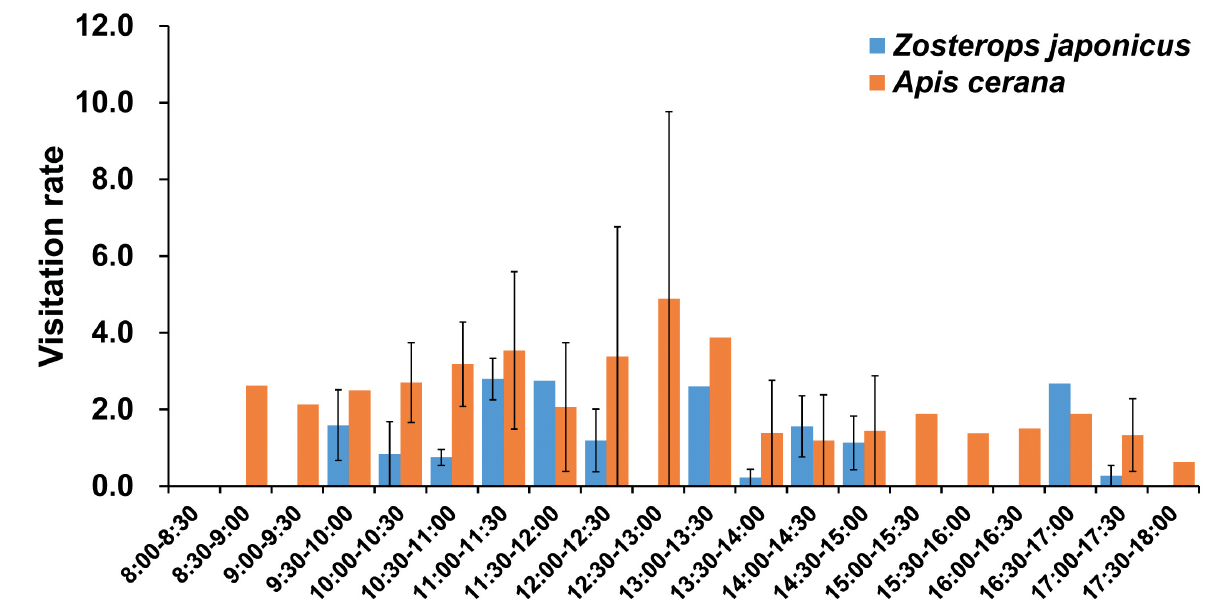
Figure 7 – Visitation rate (visits/flower/hour) of Zosterops japonicus and Apis cerana at different time periods within a day. Error bars depict the Standard